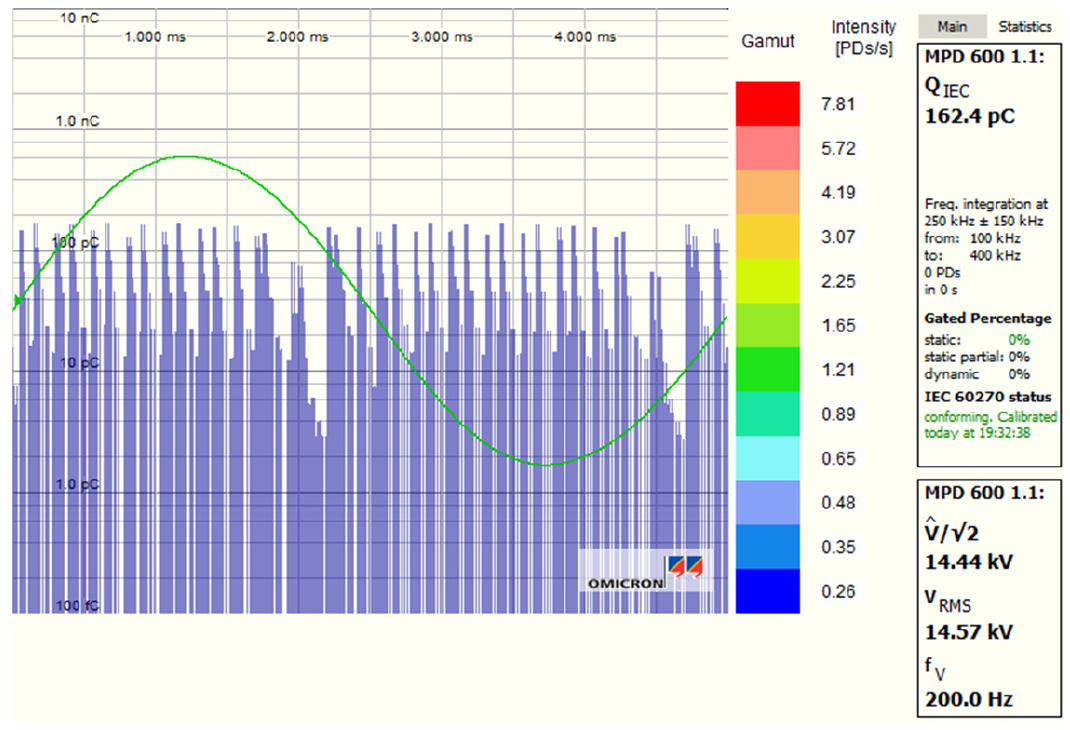
( d ) Figure 18. Experimental setup of the HV and PD tests with a test object: ( a ) Equipment in the actual HV laboratory composed of (1) HV testing transformer, (2) coupling capacitor, (3) measuring im- pedance, and (4) VT under test. ( b ) Additional capacitor. ( c ) Adjustable inductor. ( d ) Developed converter.